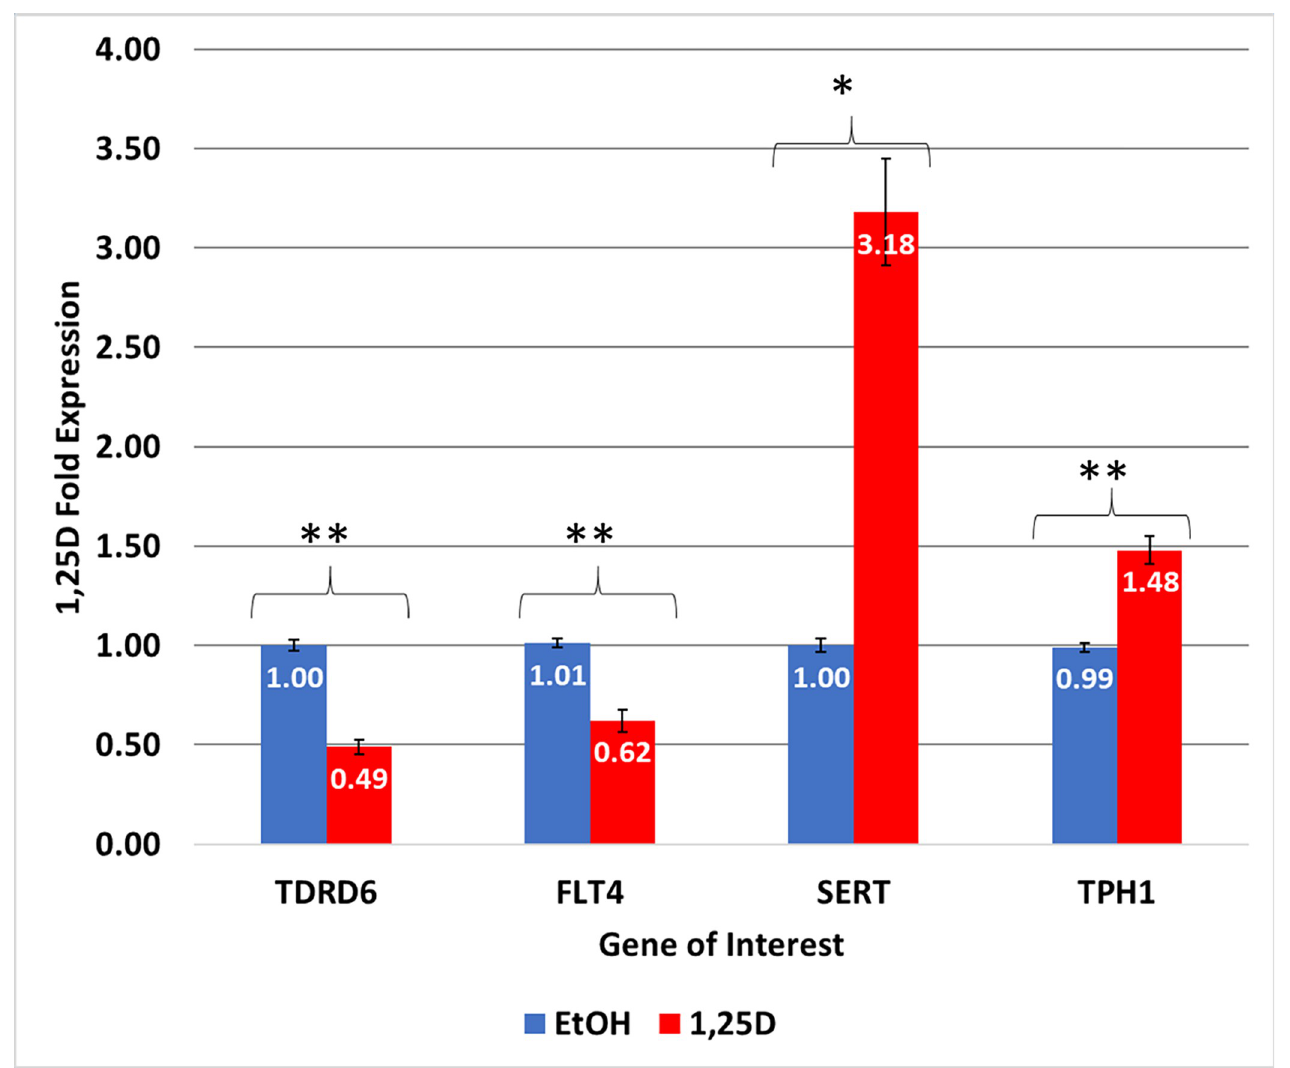
Fig 3. IBS-Associated gene regulation by 1,25D. The mRNA levels of each gene were determined using quantitative real-time polymerase chain reaction (RT- qPCR) for a total of three to six replicates. Values are reported as fold change relative to pooled control. SEM reported on bar plots. Ranges of p-values are represented as: � P < 0.005; �� P < 0.0005, t-Test: Two-Sample Assuming Equal